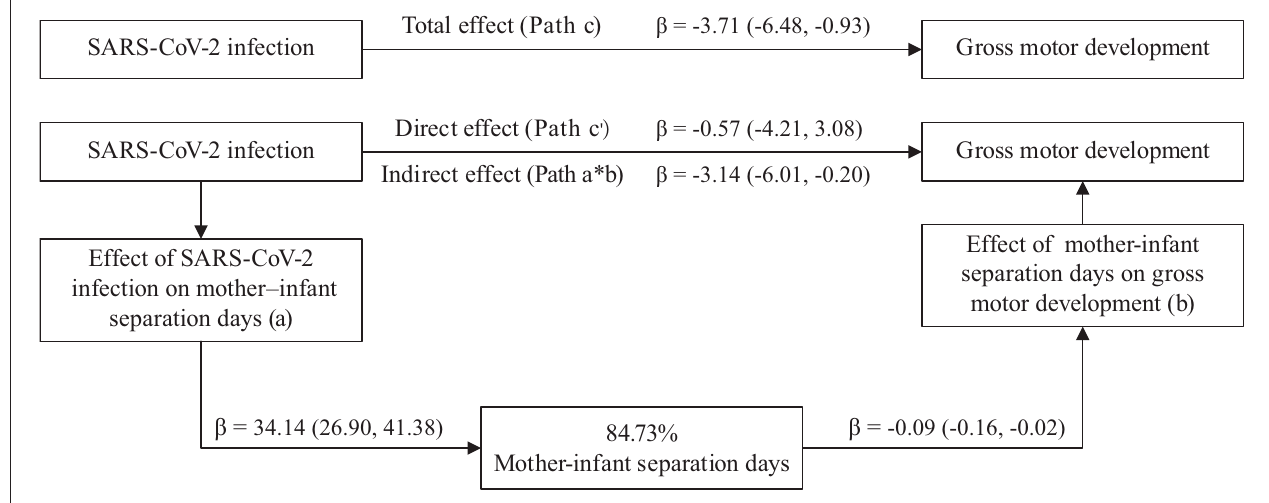
FIGURE 2 | Mediation model of SARS–CoV − 2 infection effect on gross motor development. Path a, the effect of SARS–CoV − 2 infection on mediator. Path b, the effect of mediator on gross motor development. Path a*b (indirect effect), the mediated effect of SARS–CoV − 2 infection on gross motor development by mother–infant separation days. Path c ′ (direct effect), the remaining effect of SARS–CoV − 2 infection on gross motor development extent not explained by the mediators included in the model. Path c (total effect), the total effect of SARS–CoV − 2 infection on gross motor development. In the mediation model, we adjusted maternal education (bachelor or above vs. high school or below), low birthweight (yes vs. no), infant gender (boy vs. girl), preterm (yes vs. no), admitted to NICU (yes vs. no), and breastfeeding at 3 months after delivery (yes vs.